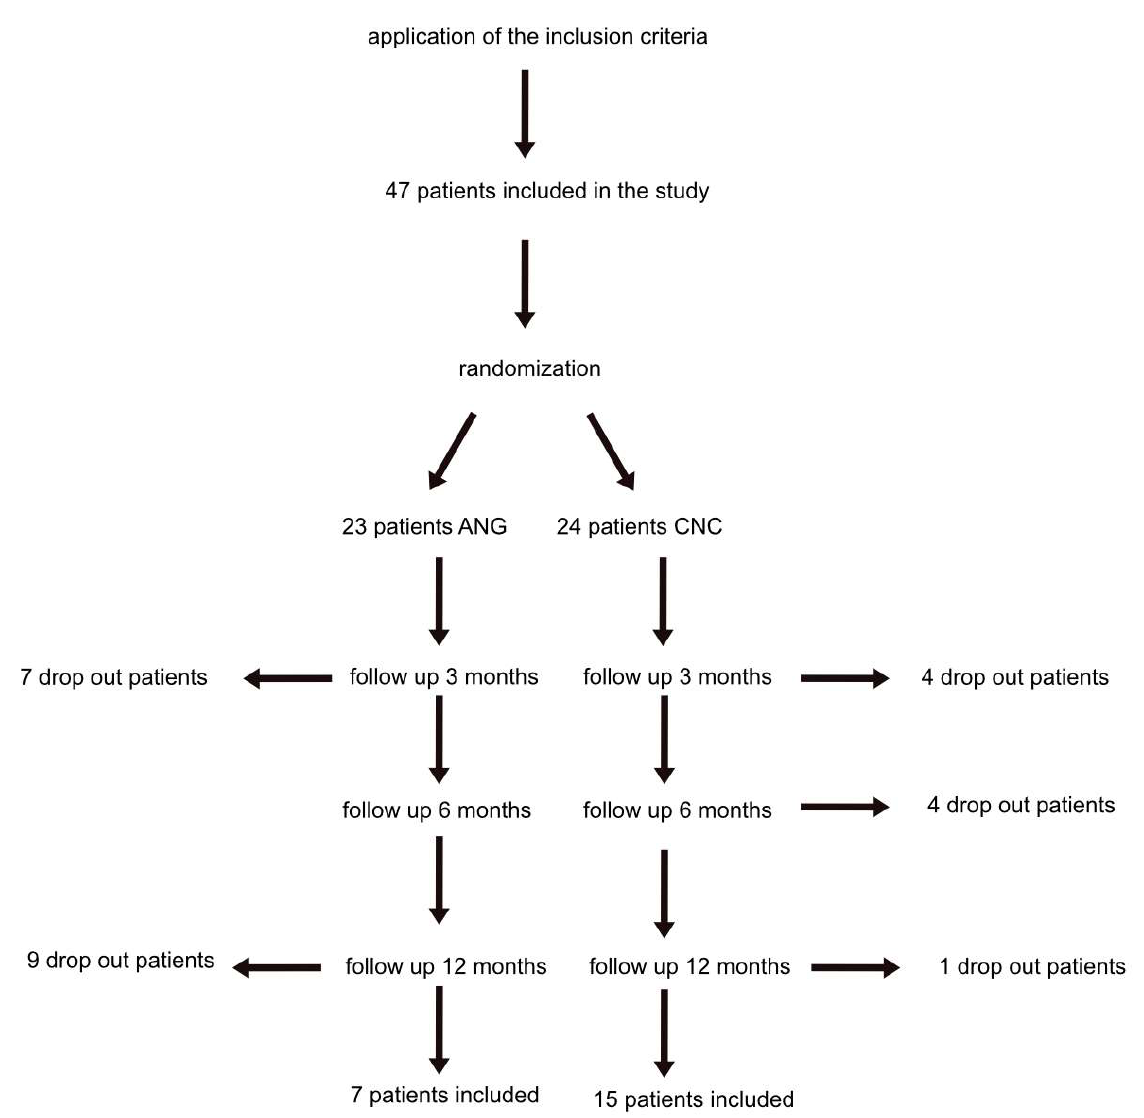
Figure 2. Overview of the patient inclusion during the study and a regeneration period of twelve